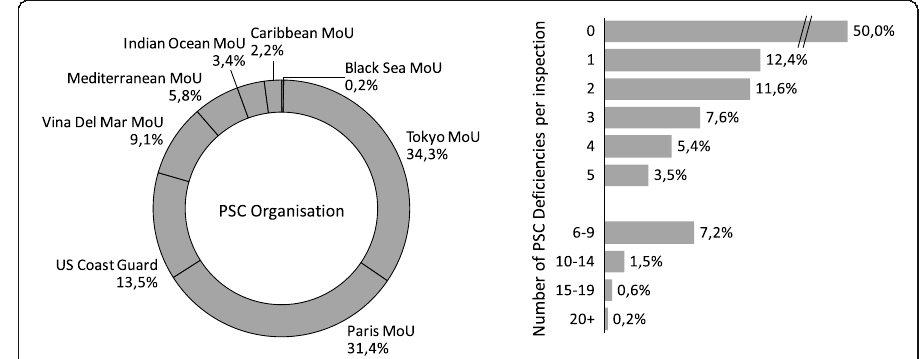
Fig. 5 Distribution of PSC data by MoU (left) and the frequency of the number of findings per PSC (right). Source: Own